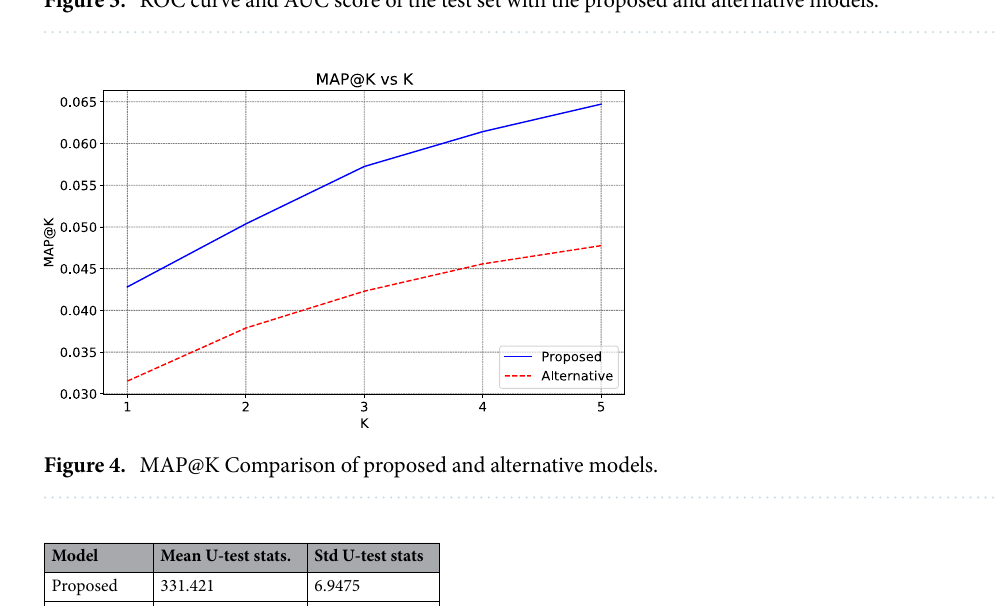
Figure 3. ROC curve and AUC score of the test set with the proposed and alternative models.